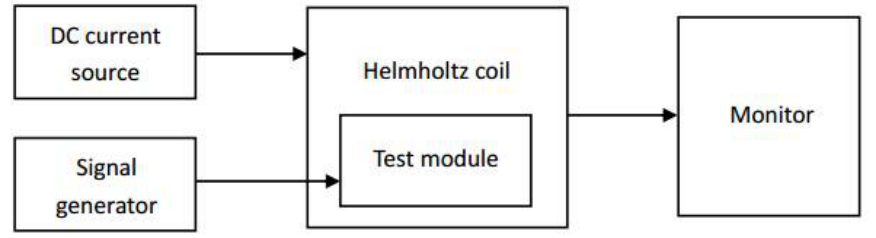
Figure 8. Experimental set up to measure the output of the magnetic field sensor. The outside of the Helmholtz coil is an eight-layer-metal shield that allows the sensor to be undisturbed by the external magnetic field.